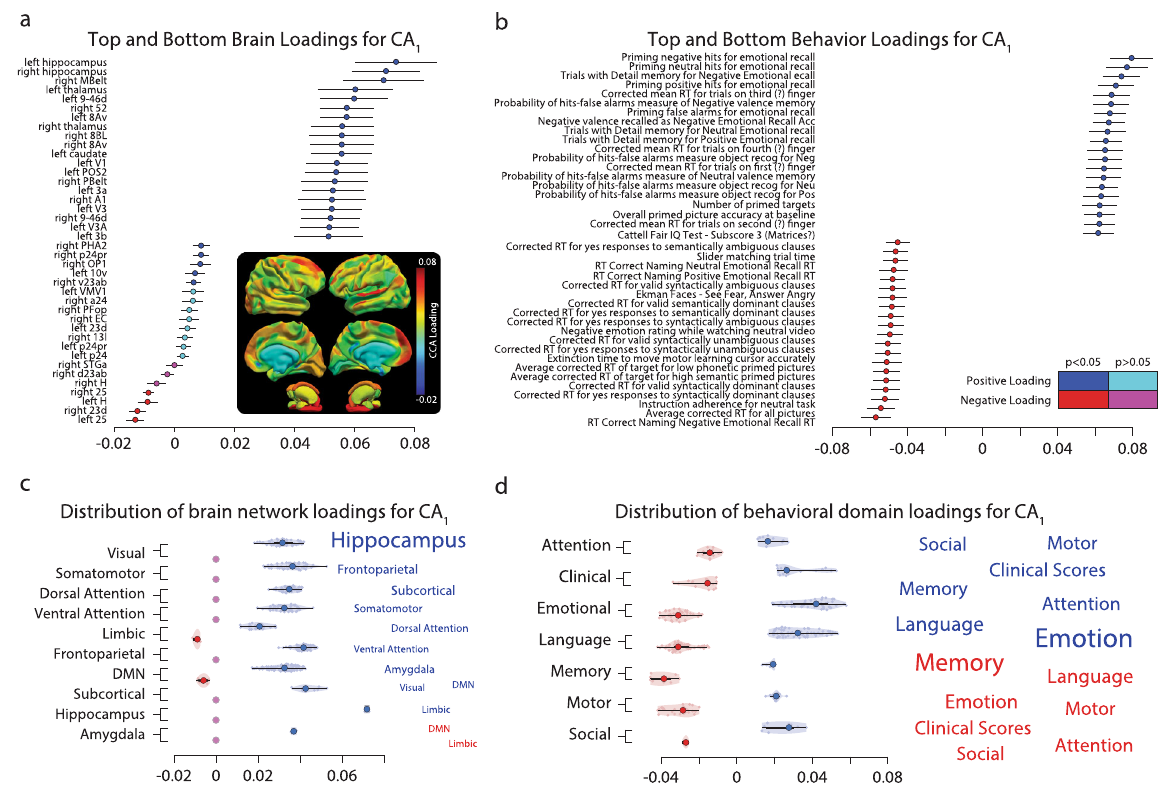
Fig. 3 Top brain network nodes and behavioral variables contributing to the canonical correlation analysis. a The highest and lowest contributing cortical nodes within the network. Top and bottom 20 CA 1 brain regions sorted by loading magnitude. Positive and signi fi cant loadings are shown in blue, negative in red. Non-signi fi cant loadings are shown in cyan or magenta. The anatomical inset visualizes the CA 1 loadings projected on the cortical and subcortical regions used to build the networks. b The highest and lowest contributing behavioral scores within the domain. The top and bottom 20 CA 1 behavioral scores sorted by loading magnitude (same conventions as in a ). c Left: Distribution of CA 1 loading by the major functional brain network as described by Y 2011 93 . Right: Word cloud of the functional network name scaled by contribution to CA 1 (the larger the font the greater the contribution). d Left: Distribution of CA 1 loading by behavioral domain. Right: Word cloud the behavioral domains scaled by contribution to CA 1 . Symbols report mean ± 2 standard errors (s.e.) estimated across 10,000 cross-validation throws of M 1 . Violin plots report the full underlying distributions of the data, when